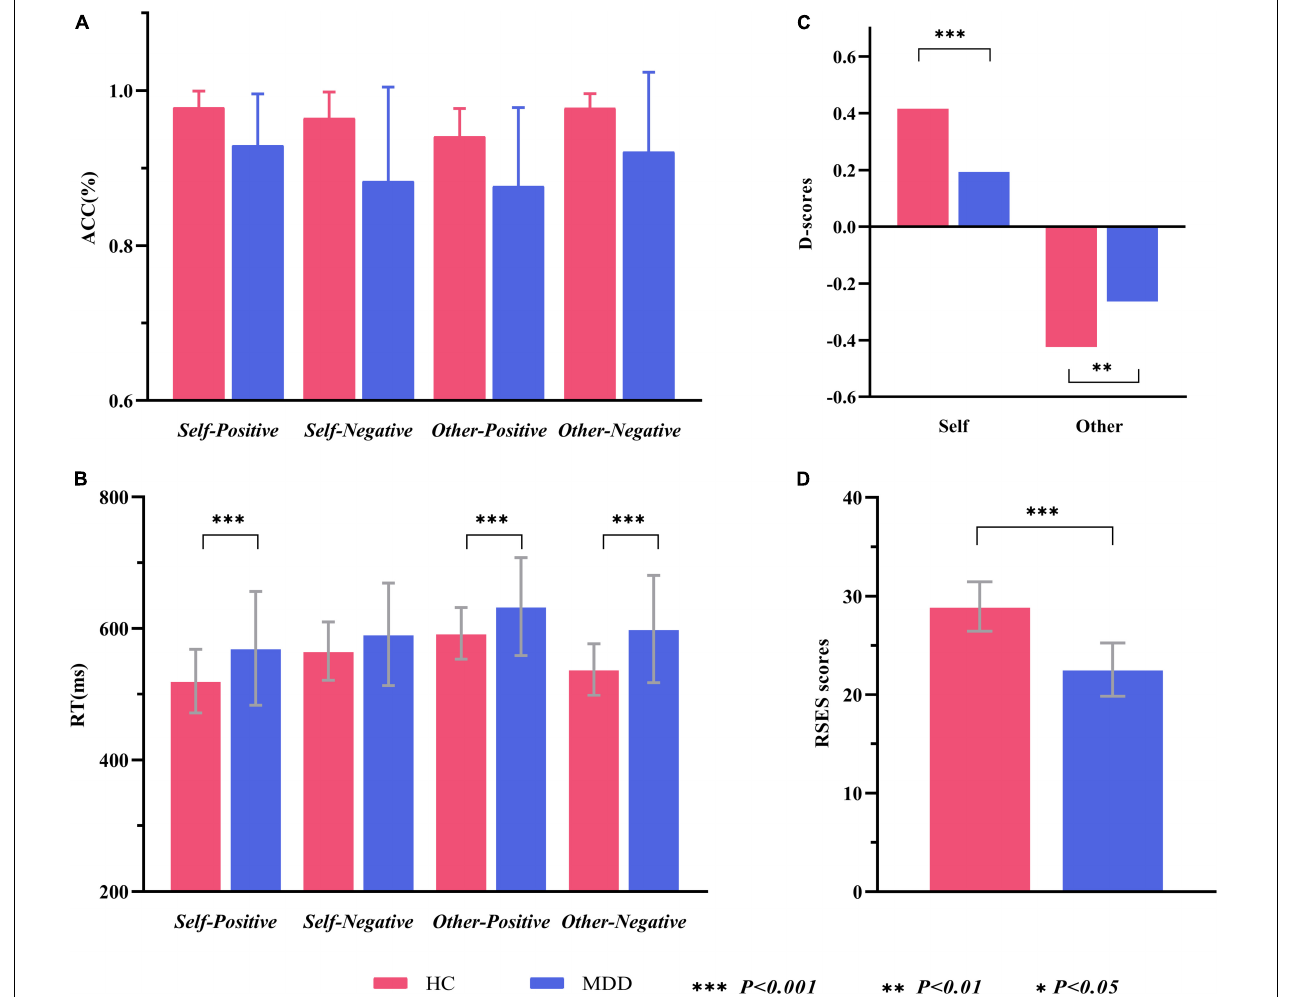
FIGURE 2 | Within- and between-group comparisons of behavioral data in the self-esteem GNAT. (A) Grand average hit rate of go-task in different conditions and groups. (B) Grand average reaction time of go-task in different conditions and groups. (C) Self-D scores and Other-D socres in two groups. (D) Average RSES scores of two groups. ACC, accuracy (hit rate of go-task); RT, reaction time; RSES, Rosenberg Self-Esteem